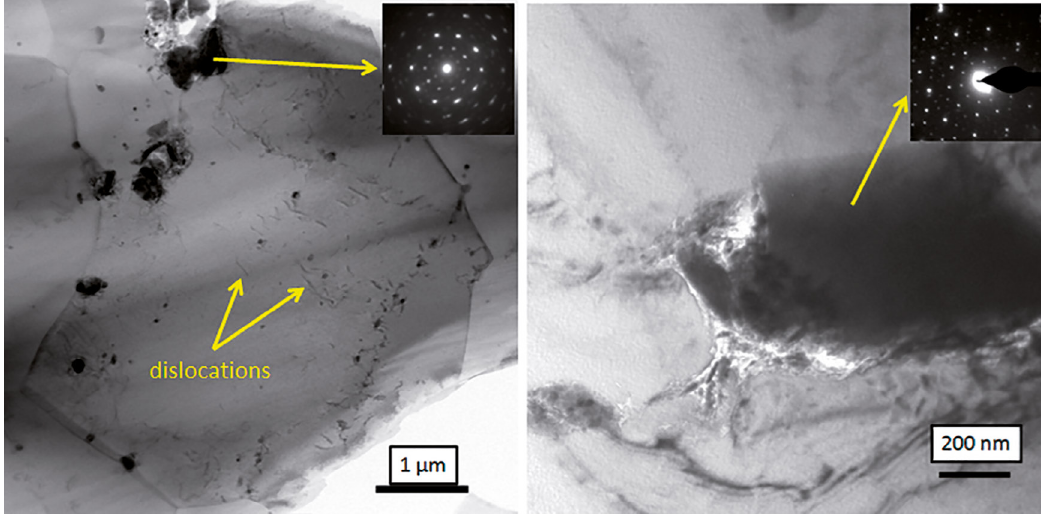
Figure 3: TEM bright field image with selected area electron diffraction pattern of the quasicrystalline phase showing the five-fold rotational symmetry.(a) Al/AlCuFe composite. (b) Al/AlPdMn